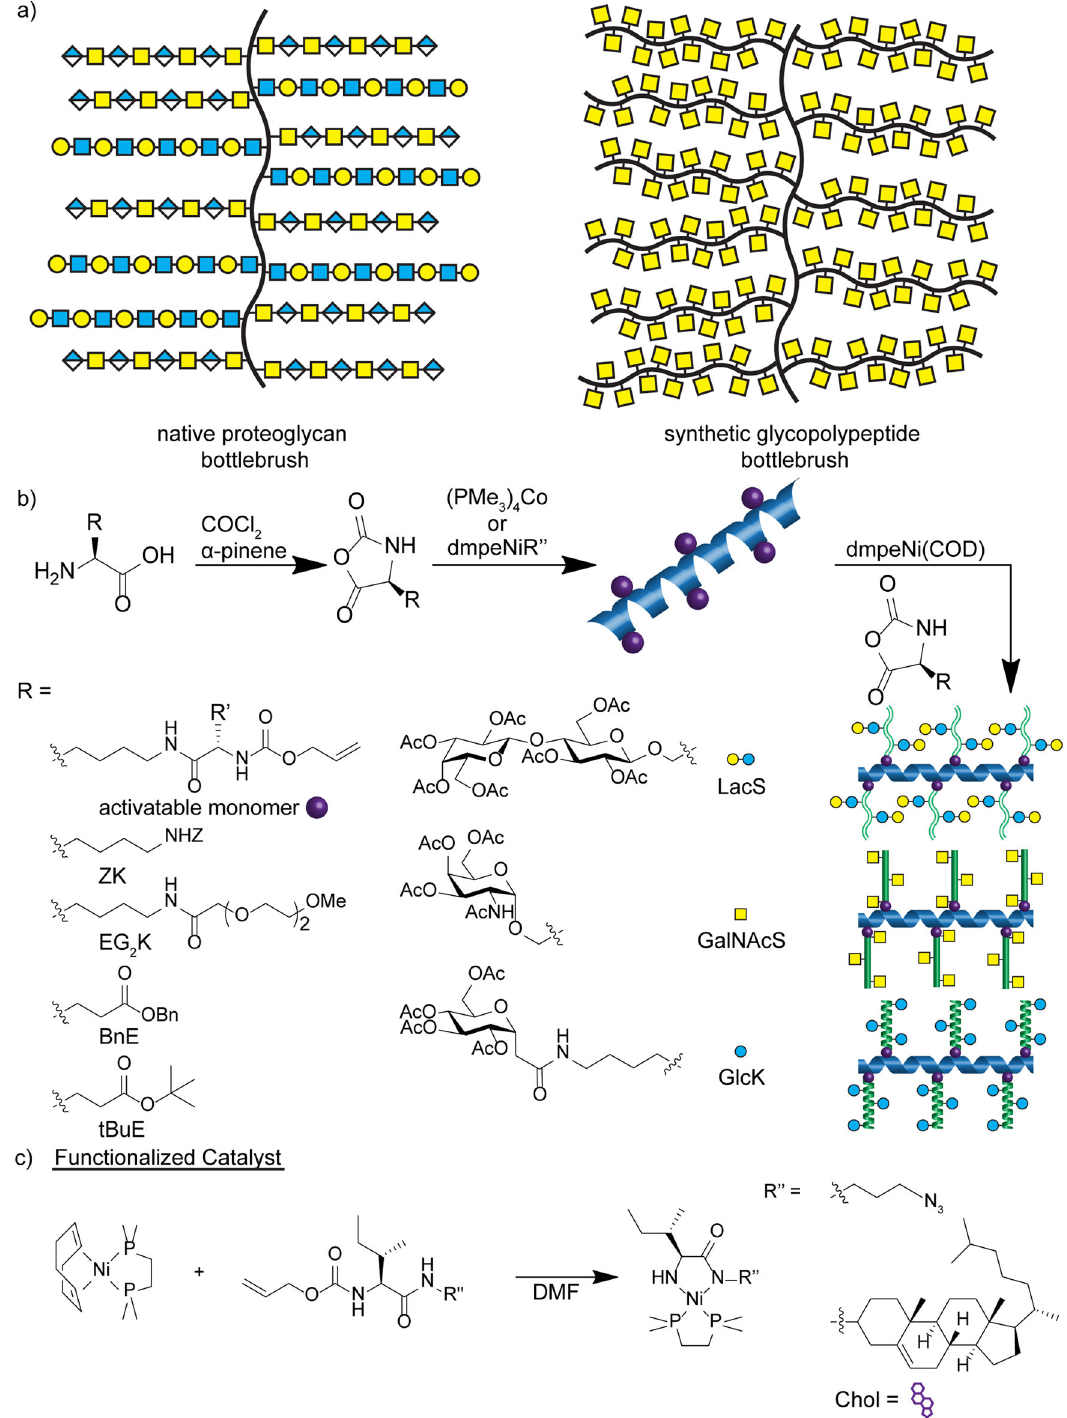
Fig. 1 Cartoon representations of native proteoglycans vs. our synthetic glycobrushes, which are prepared via two-step, one-pot NCA polymerization. a Comparison of a representative native proteoglycan bottlebrush (i.e., aggrecan with polypeptide backbone and chondroitin sulfate, and keratin sulfate polysaccharide chains) with our synthetic glycobrushes. b Synthetic route to chemically tunable glycobrush-based dual-catalysis, one-pot NCA polymerization. Chain length, graft density, glycosylation density, and pattern are tuned via NCA monomer feed ratios and equivalents of transition metal catalysts. R ’ = CH 2 CH 2 SCH 3 for Met-linked AMK or CH(CH 3 )CH 2 CH 3 for Ile-linked AIK. c Functional Ni 0 catalysts used in this study to install chemical groups of interest at the chain initiation